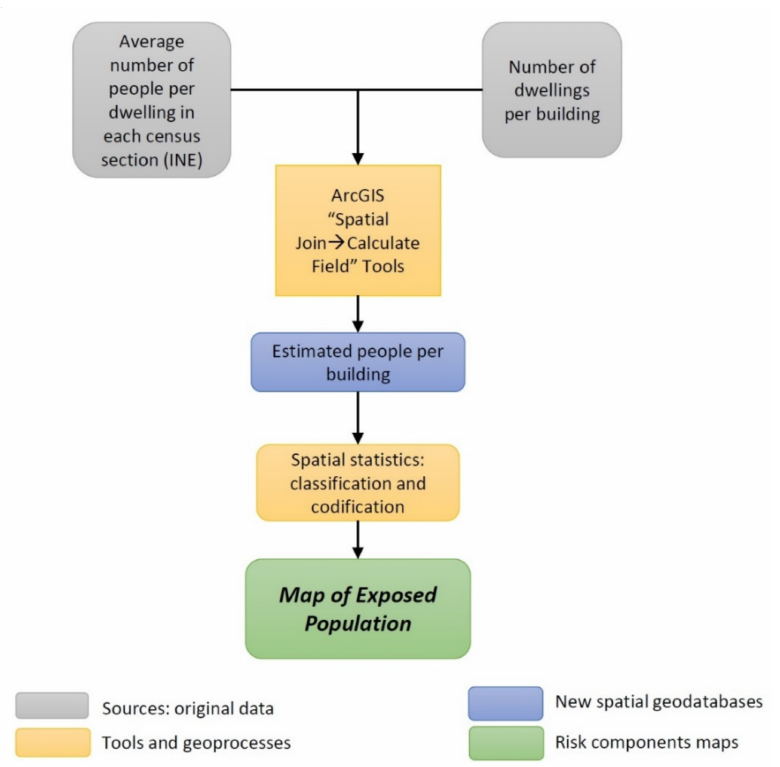
Figure 2. Flowchart of the exposed population map. Own